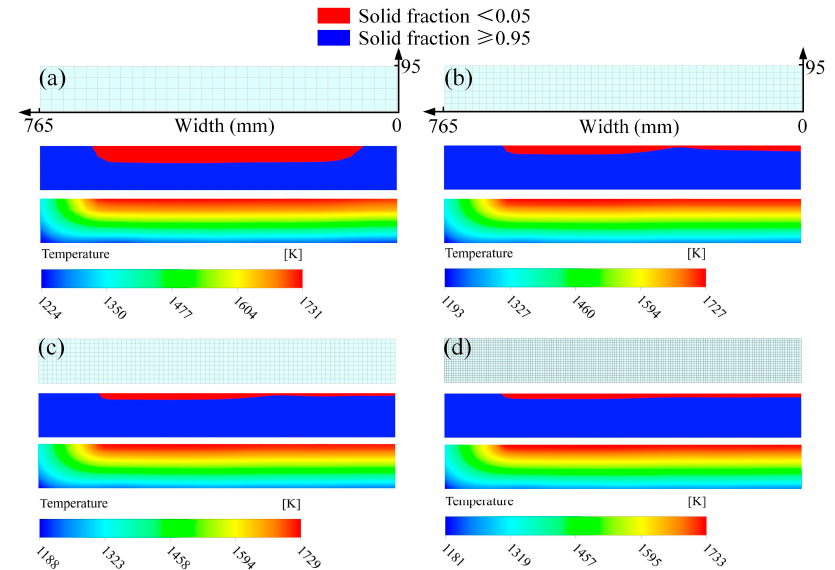
Figure 6. Solidification profile and temperature field in the transverse section (17.56 m from the meniscus) with different cell sizes: ( a ) 25 × 25 mm 2 , ( b ) 15 × 15 mm 2 , ( c ) 10 × 10 mm 2 , ( d ) 5 × 5 mm 2 .